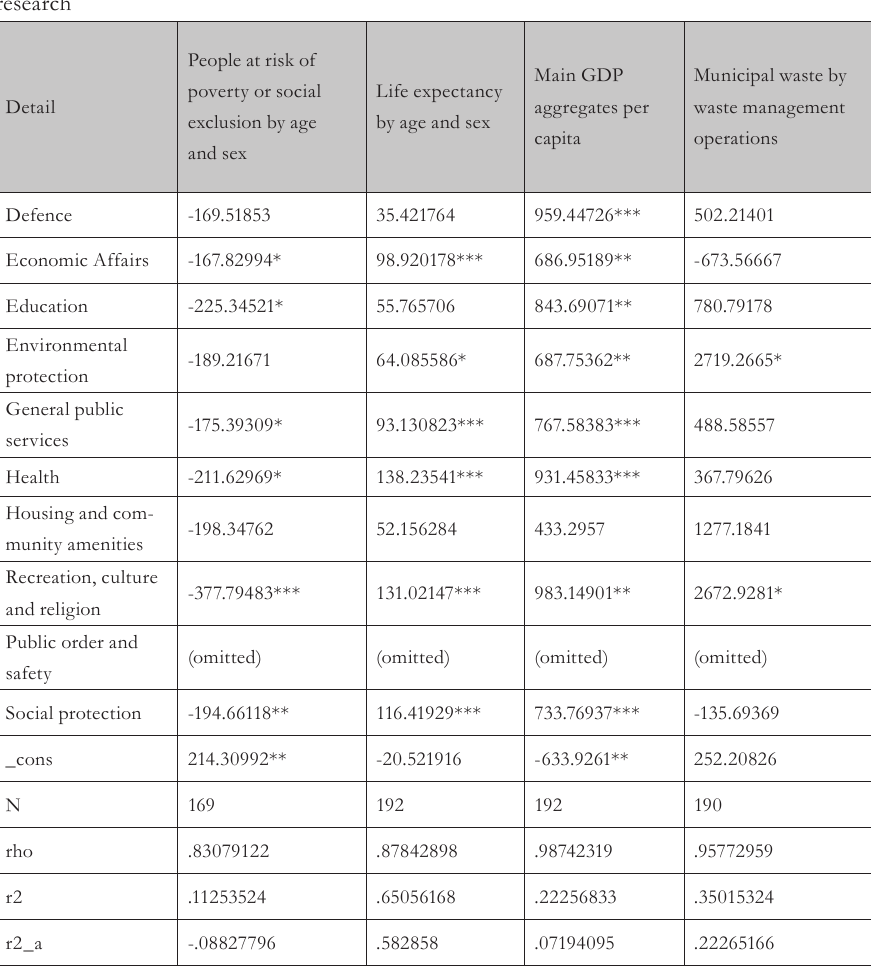
Tab. 2 – Results of the fixed effects model on the following indicators: People at risk of poverty or social exclusion by age and sex; Life expectancy by age and sex; Main GDP aggregates per capita, Municipal waste by waste management operations (kilograms per capita). Source: